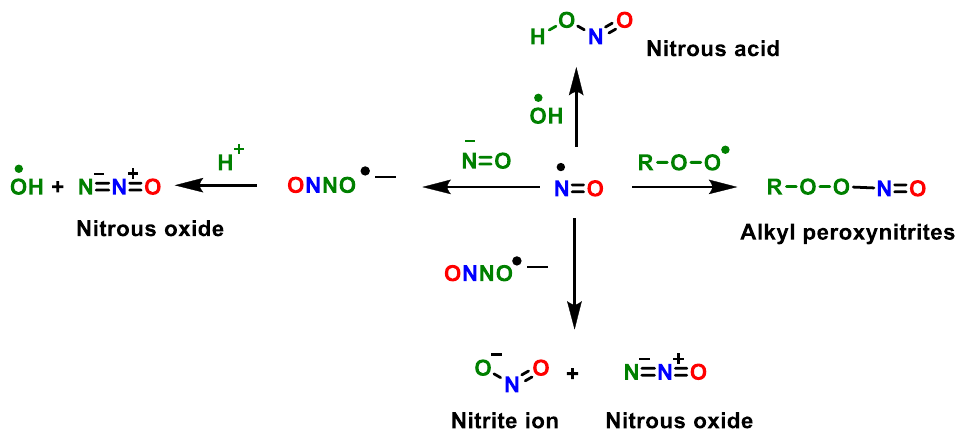
Figure 5. Secondary reactions of peroxynitrite and another radical.